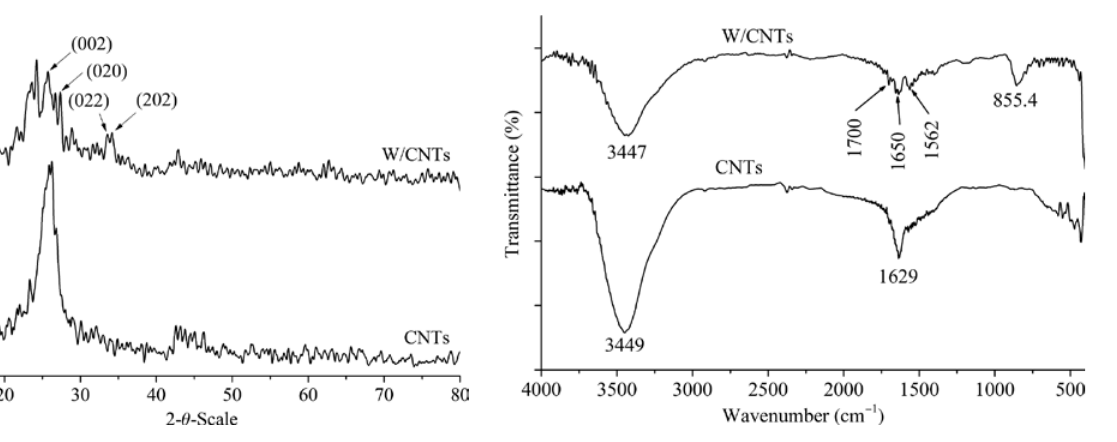
Figure 5: FT-IR spectra of CNTs and